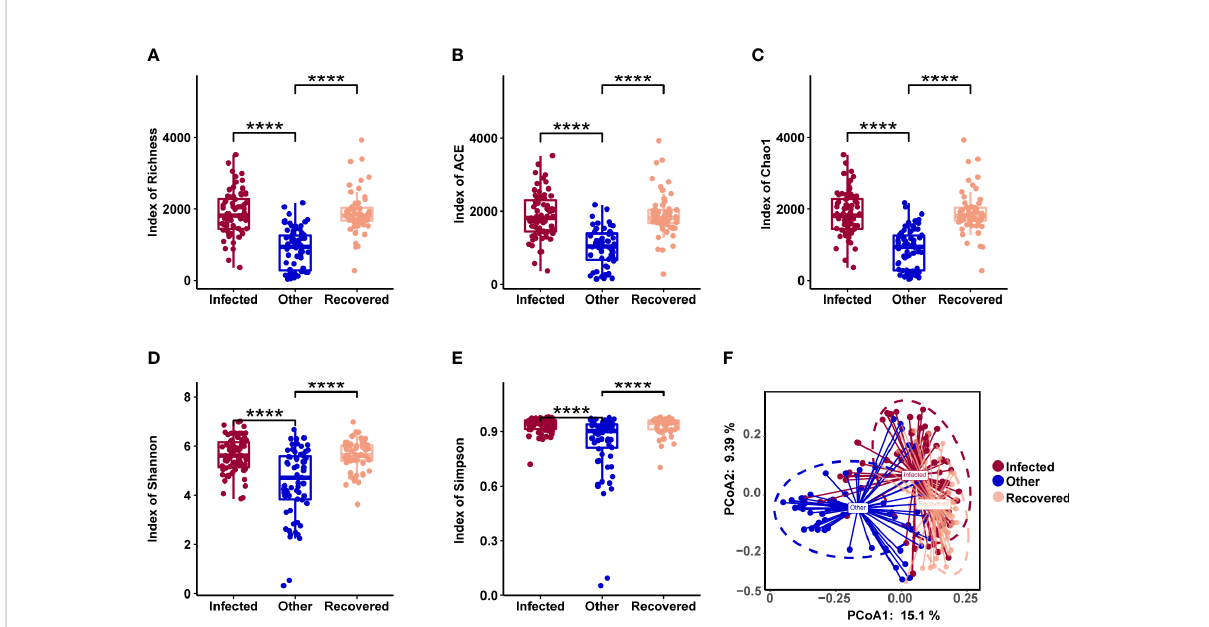
FIGURE 3 Microbial diversity associated with COVID-19. (A-E) Alpha diversity includes richness (A) , ACE (B) , Chao1 (C) , Shannon (D) , and Simpson (E) . **** indicates a p-value < 0.0001 (Wilcoxon test). (F) Principal coordinates analysis (PCoA) of samples using a Jensen-Shannon Divergence (JSD) distance.